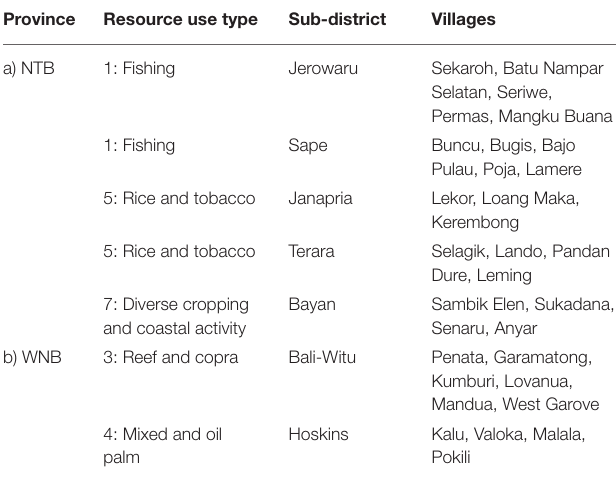
TABLE 1 | Characteristics of the case study sub-districts in NTB and WNB, and villages assessed within them.